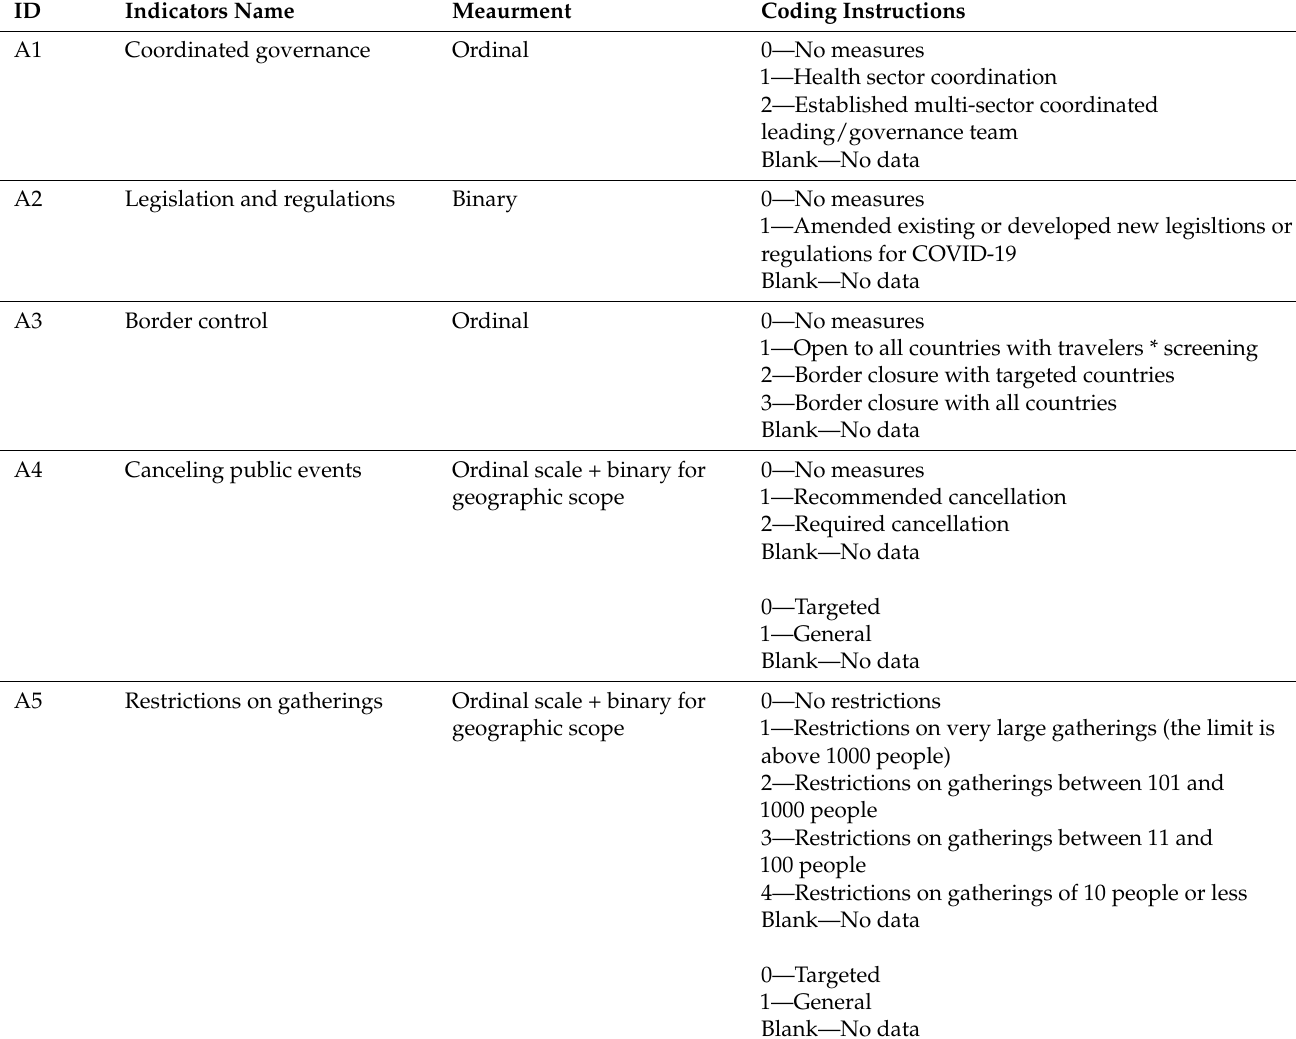
Table A1. Indicator